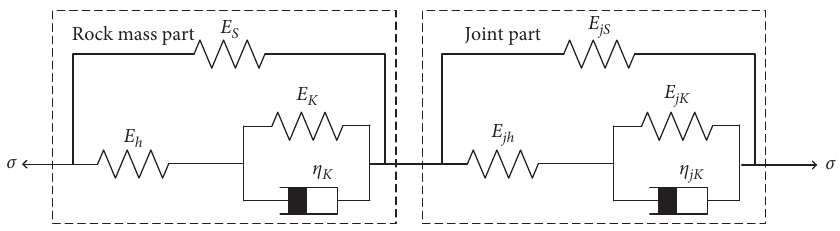
Figure 1: Coupling effect model of creep deformation and anchor prestress loss of anchored rock